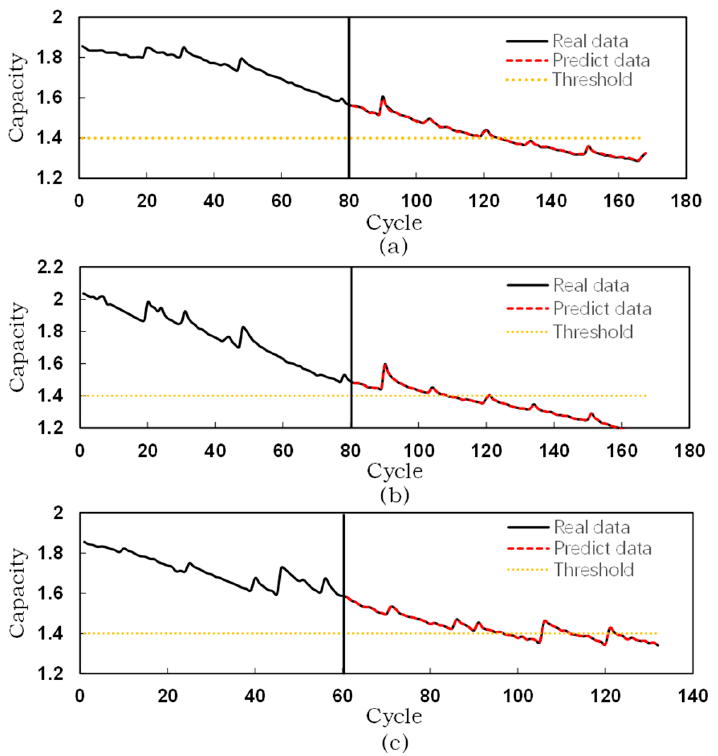
Figure 8. Prediction results for B0005 and B0006 with 80 training samples and B0018 with 60 training samples. ( a ) B0005, ( b ) B0006, and ( c ) B0018.